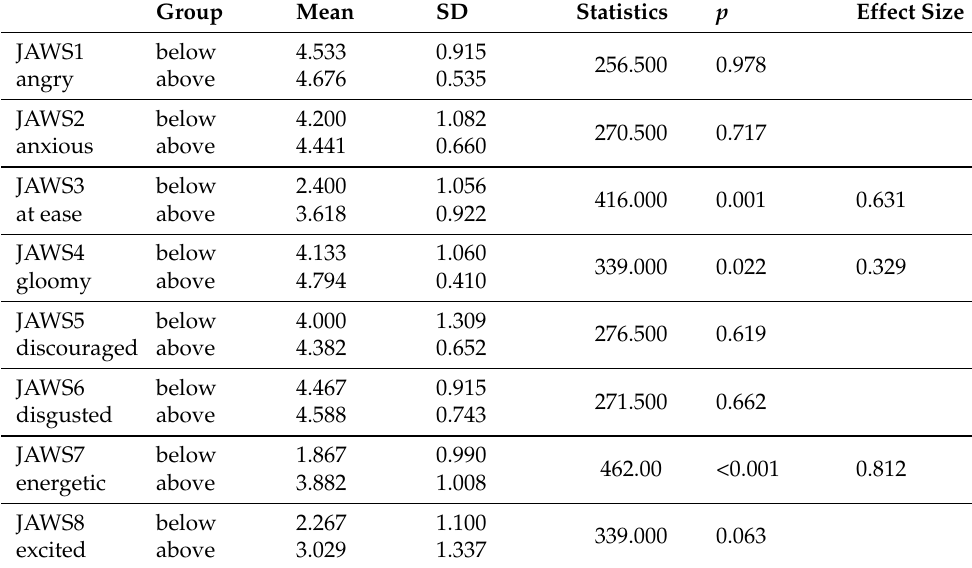
Table 3. The intensity of individual emotions measured by the JAWS